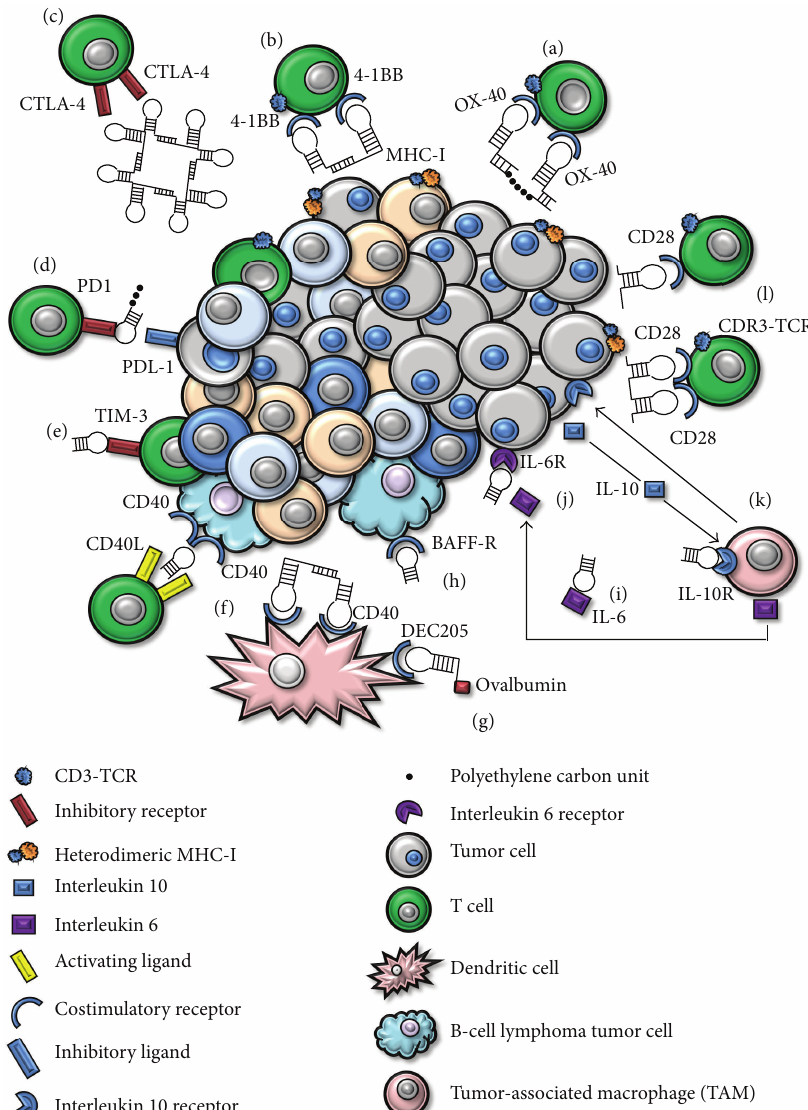
Figure 2: Schematic representation of main aptamers used in cancer immunotherapy. (a) OX-40. (b) 4-1BB. (c) CTLA-4. (d) PD1. (e) TIM-3. (f) CD40. (g) DEC205. (h) BAFF-R. (i) IL-6R. (j) IL-6. (k) IL-10R. (l)